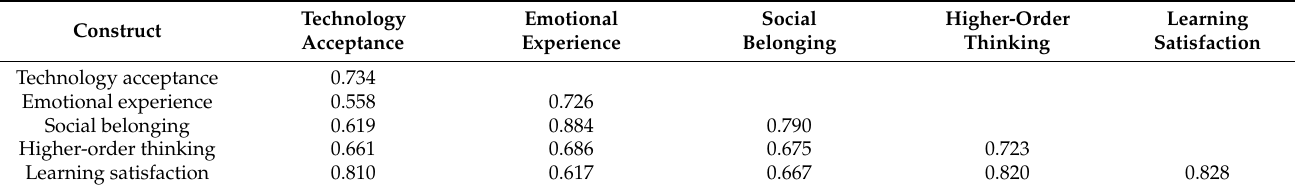
Table 2. Discriminant validity